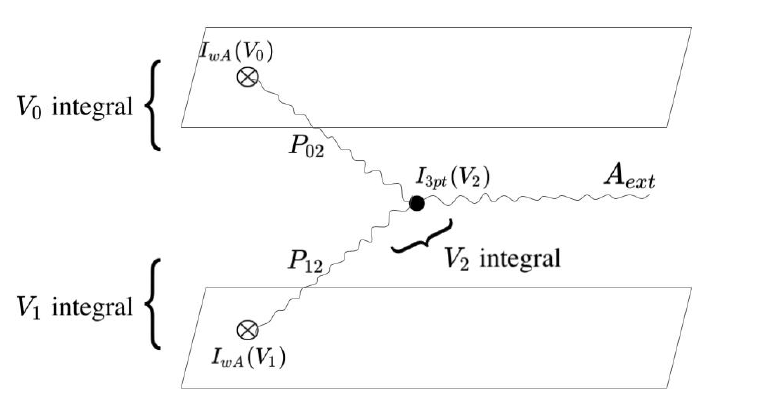
Figure 10: The 1-loop Feynman diagram associated with the W ∞ → W ∞ ⊗ W ∞ coproduct. All the ingredients are explicitly